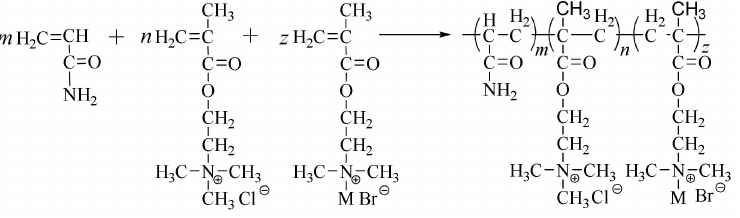
Figure 12. The synthetic route for preparation of